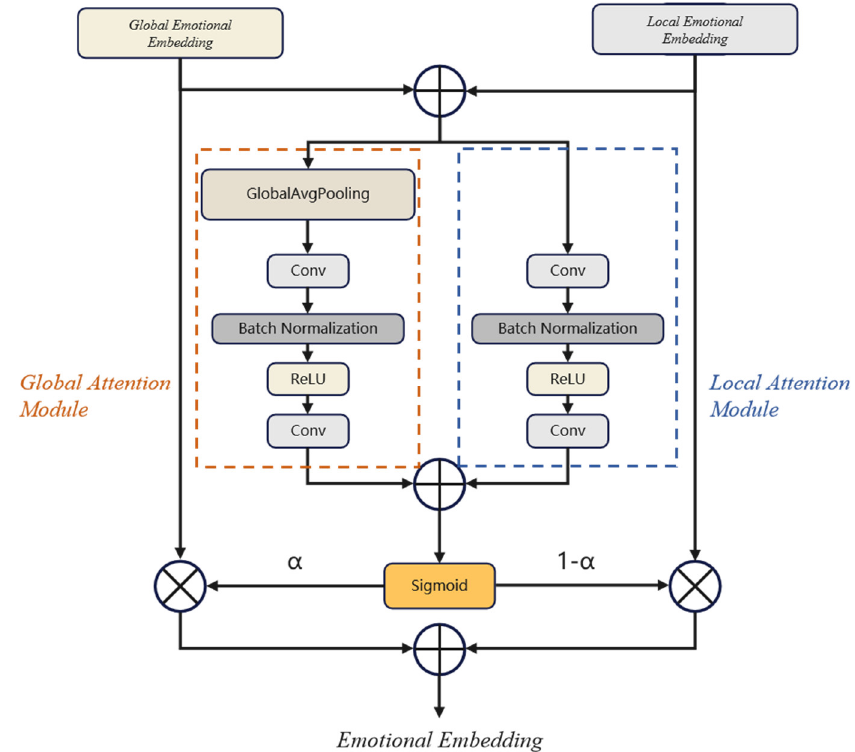
Figure 6. Architecture of the emotion feature fusion module.